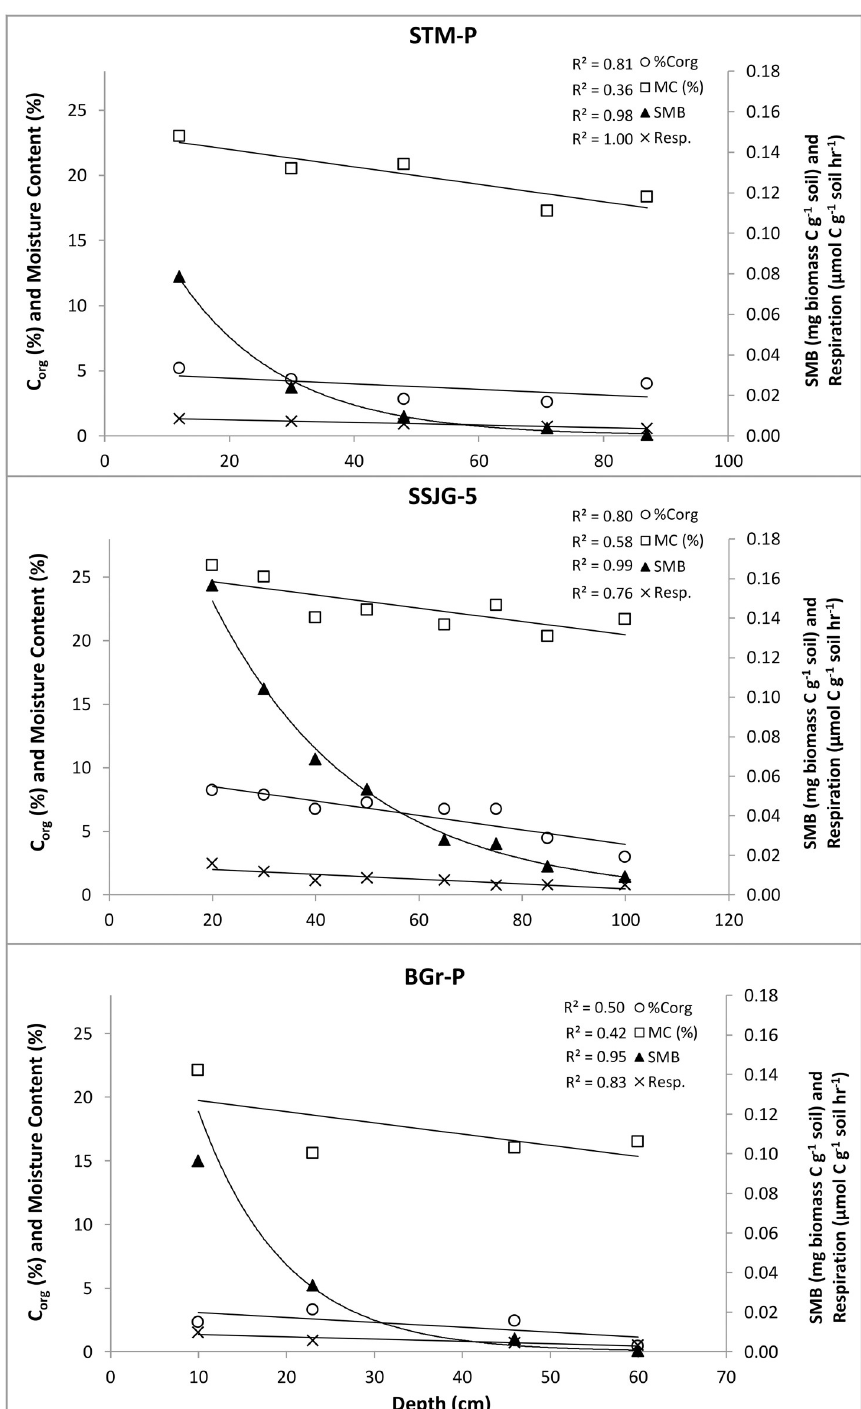
Fig 3. Relationship between soil variables and depth on three sites (STM-P, SSJG-5, and BGr-P). Phenoloxidase enzyme activity was generally higher in subsoils than in topsoil (Fig 4). Enzyme activity was lowest in BGr-P samples for the top 3 depth profiles but similar to values for STM-P and SSJG-5 at subsoil depths, between 40–50 cm. Phenoloxidase activity exhibited a positive correlation with depth on all three sample sites assayed: STM-P, SSJG-5, and